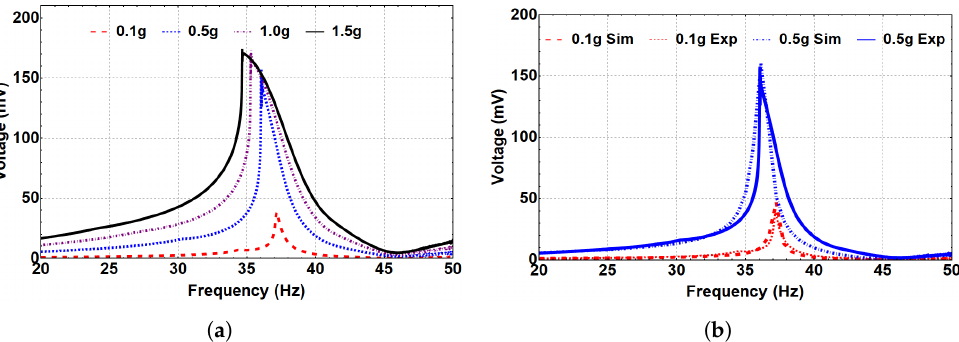
Figure 9. The frequency–voltage curve for different excitation levels at the bistable regime ( d = 5 mm). ( a ) Experimental results. ( b ) Simulated results with experimental